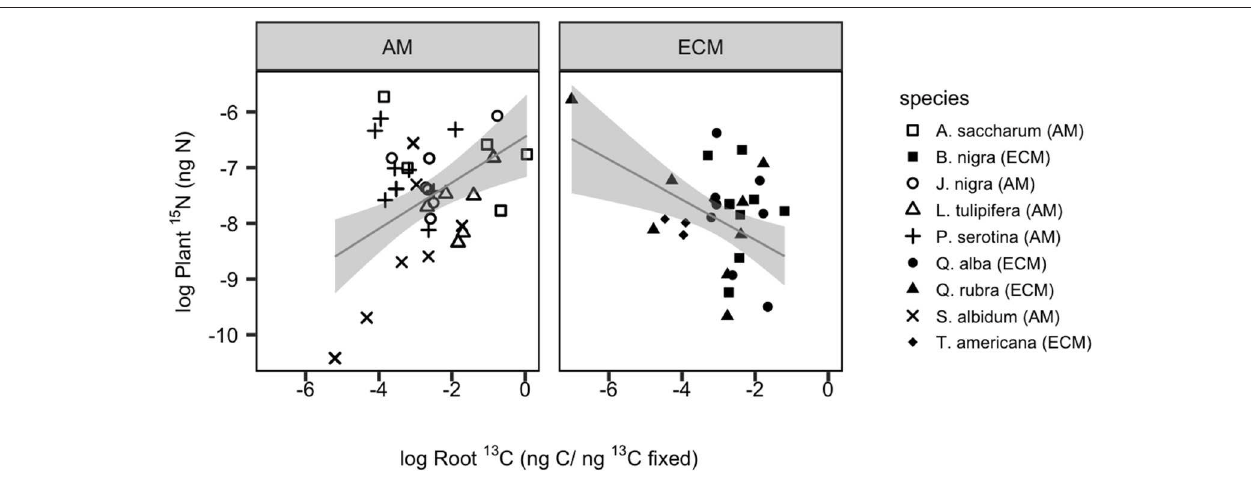
Frontiers in Forests and Global Change |